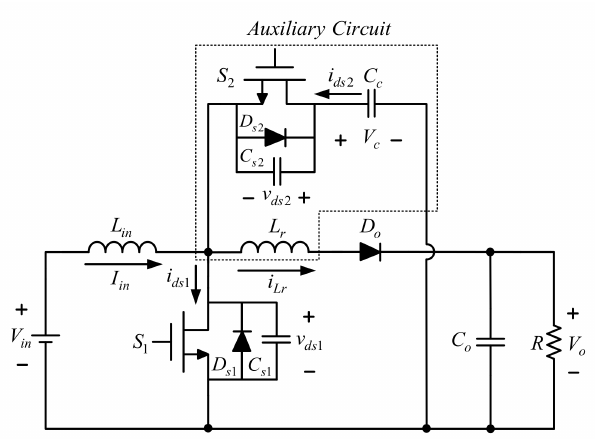
Figure 1. Proposed active clamp boost converter.